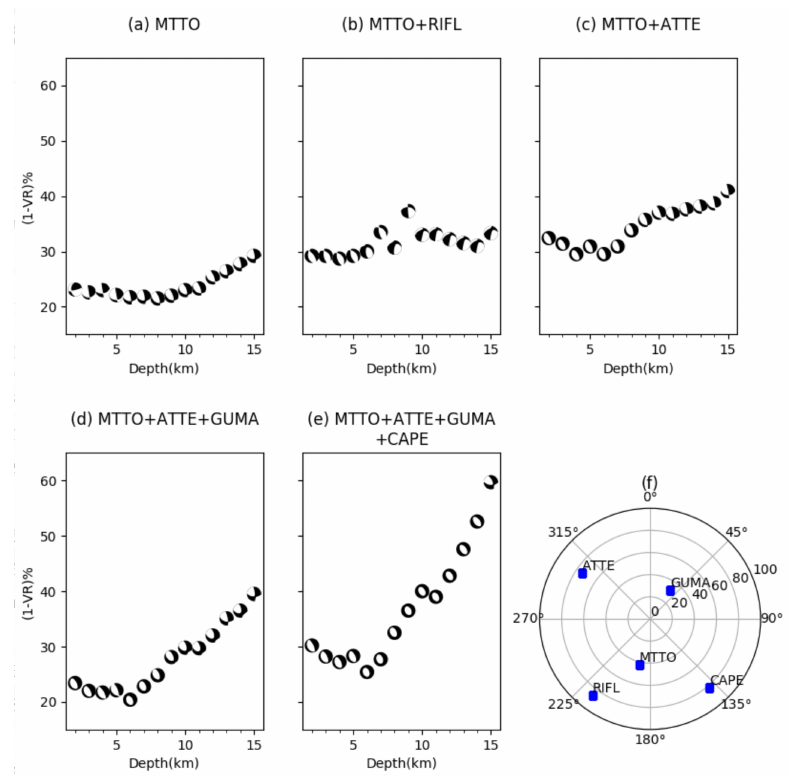
Figure 7. Results of the sparse network tests and the distribution of stations. ( a – e ) variance reductions (VRs) and focal mechanisms of the Norcia earthquake, obtained by different numbers of stations, at depth from 2 km to 15 km; ( f ) Azimuthal and epicentral distribution of stations used in the sparse network tests; the origin point is the epicenter of the Norcia